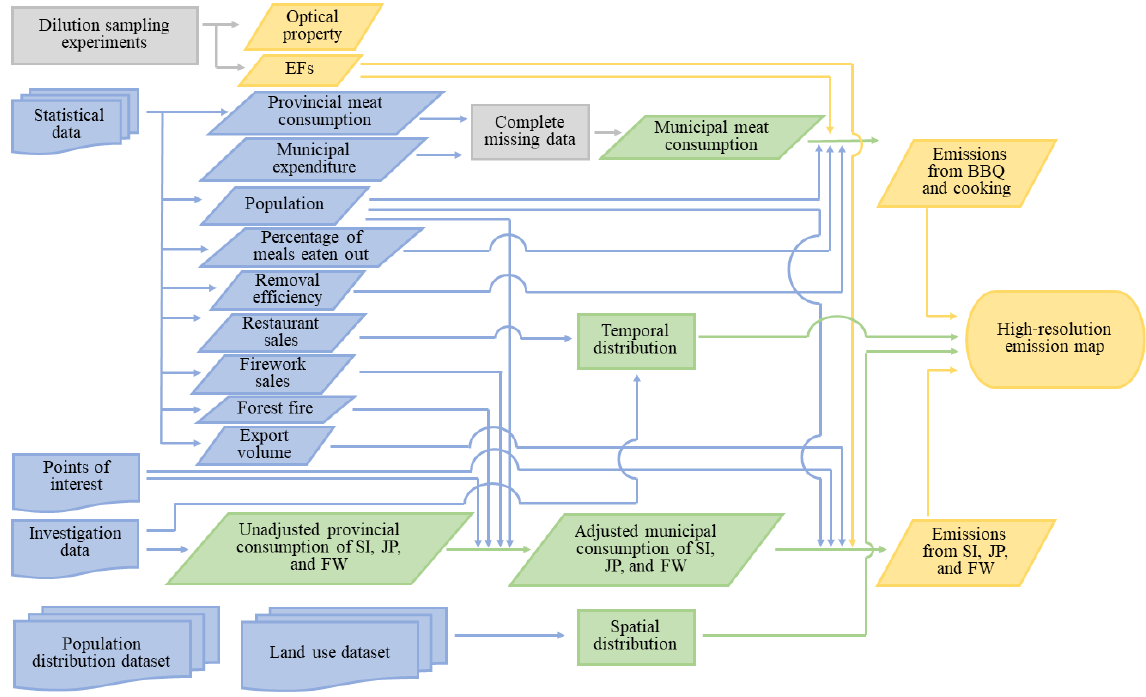
Figure 1. Methodological framework for establishing a high-resolution emission inventory for the five missing sources (FMSs).